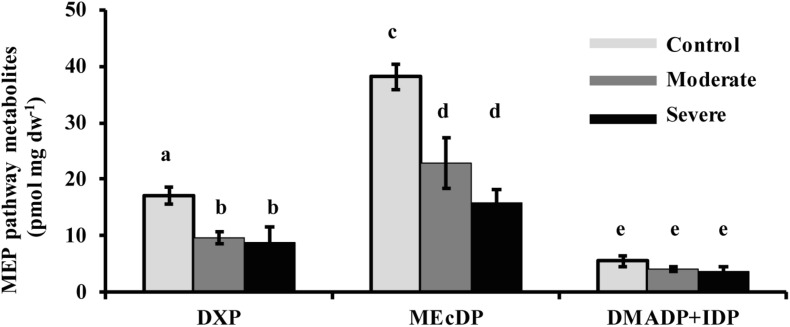
Drought reduced the concentrations of the MEP pathway intermediates, DXP and MEcDP, but not DMADP + IDP in needles. Data shown are means of five biological replicate ± SE. Different letters indicate significant differences at P < 0.05.